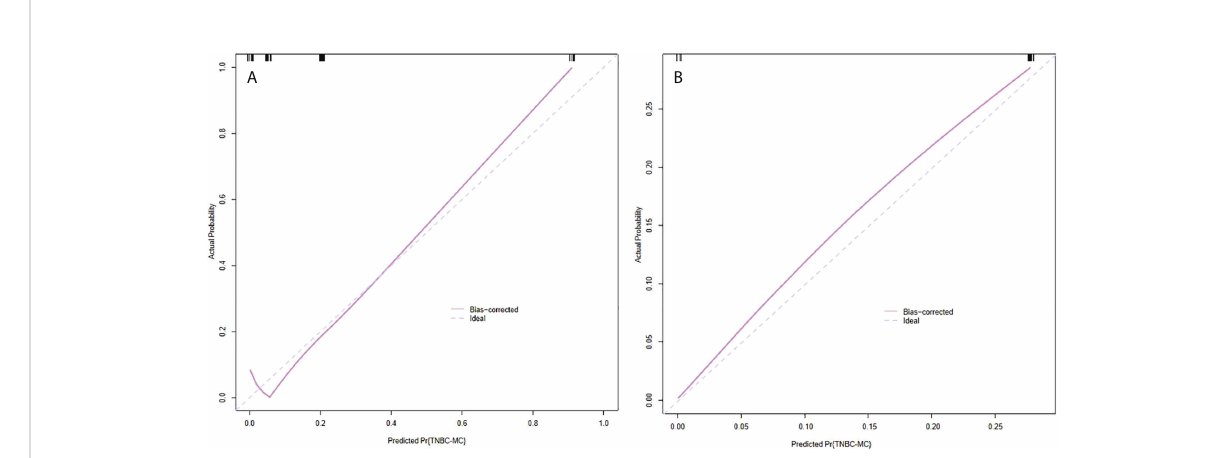
FIGURE 4 Calibration slope of nomogram in the training set (A) and validation set (B) . The calibration curve was used to represent the relationship between the predicted value and the true value. The x-axis represented the probability of TNBC-MC predicted by the nomogram, and the y-axis represented the actual TNBC-MC rate. The blue line in the middle represented the accurate prediction. And the purple line represented the predictive power of the nomogram. The closer the purple line and the blue line were, the better the prediction effect of the nomogram. Both p